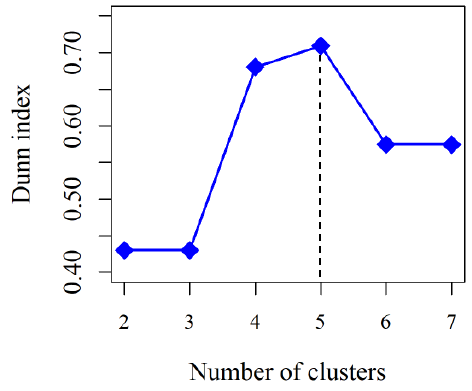
Figure 11. Dunn index for the testing datasets clustering.